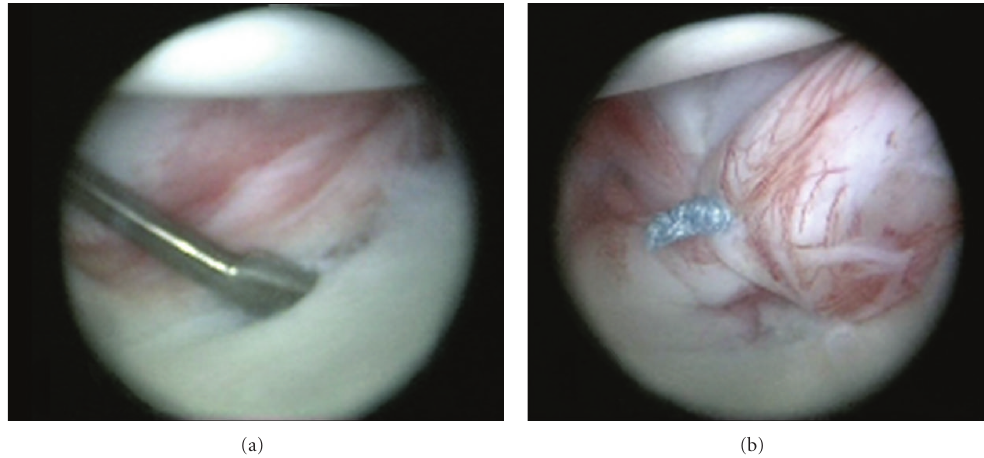
Figure 2: Arthroscopic views of the lesion (a) and after capsulolabral repair and rotator interval closure